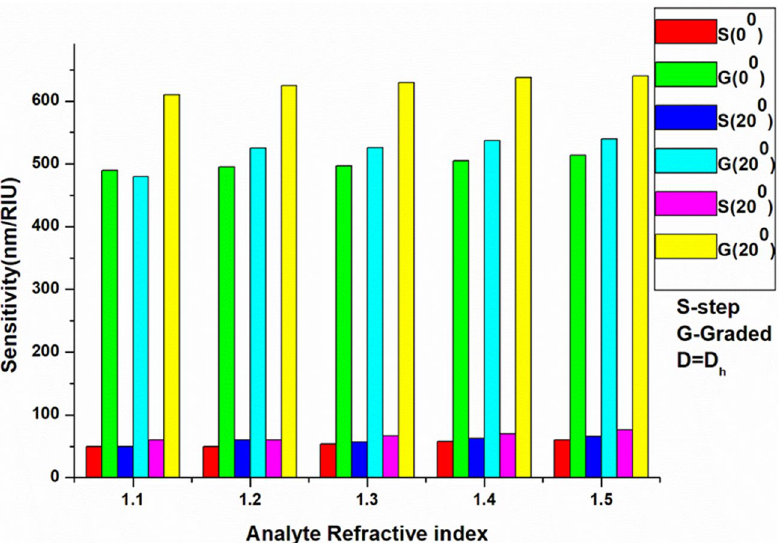
Figure 5. Sensitivity comparison of step index and graded index structure with different incidence angle and defect layer thickness D = D h.